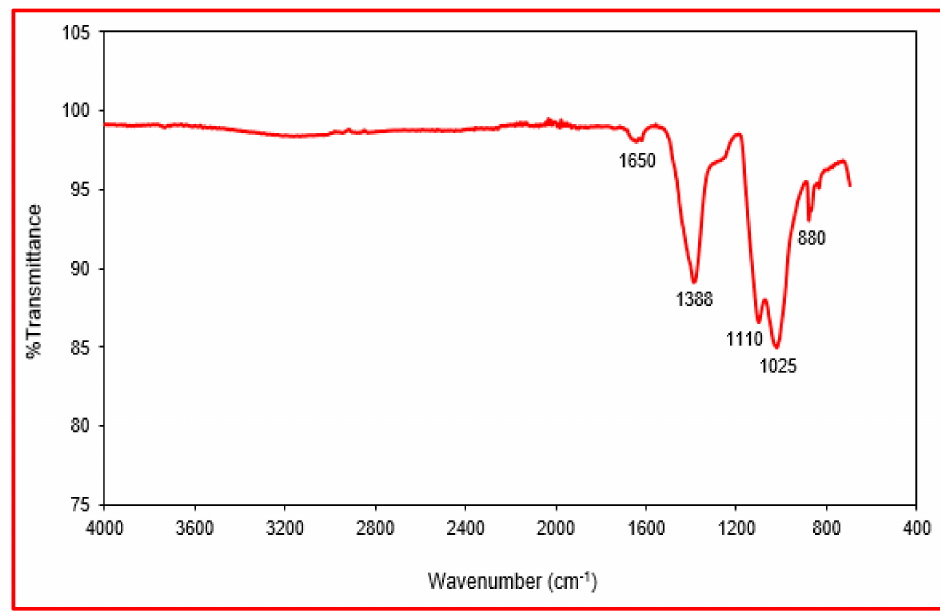
Figure 3. Fourier transform infrared (FTIR) spectrum of CPP at 600 ◦